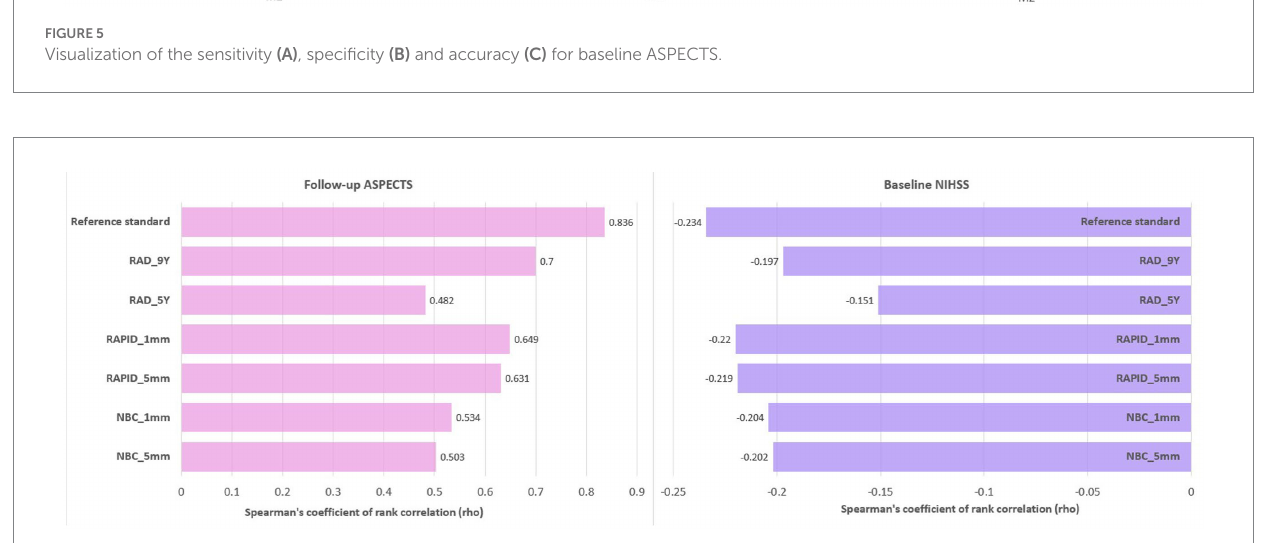
FIGURE 6 Bar plot of correlation coefficients (rho) between baseline NIHSS scores, follow-up ASPECTS, and baseline